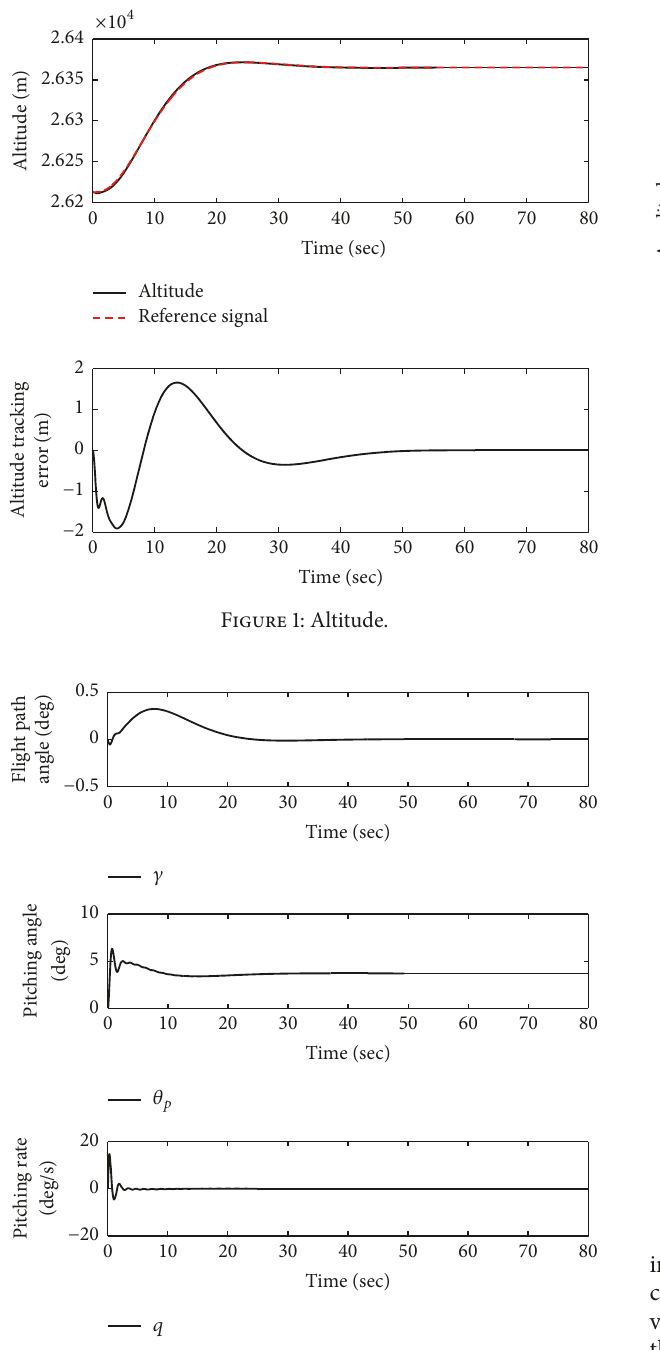
Figure 2: FPA, pitching angle, and pitching rate.